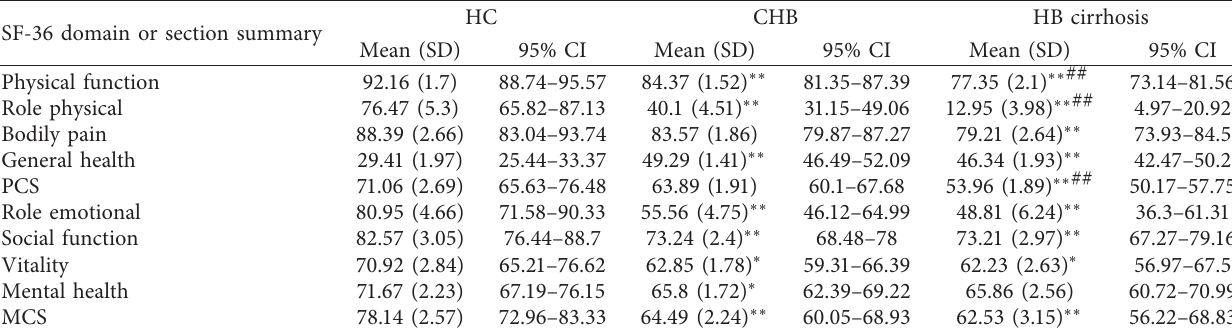
Table 2: Comparison of SF-36 results by